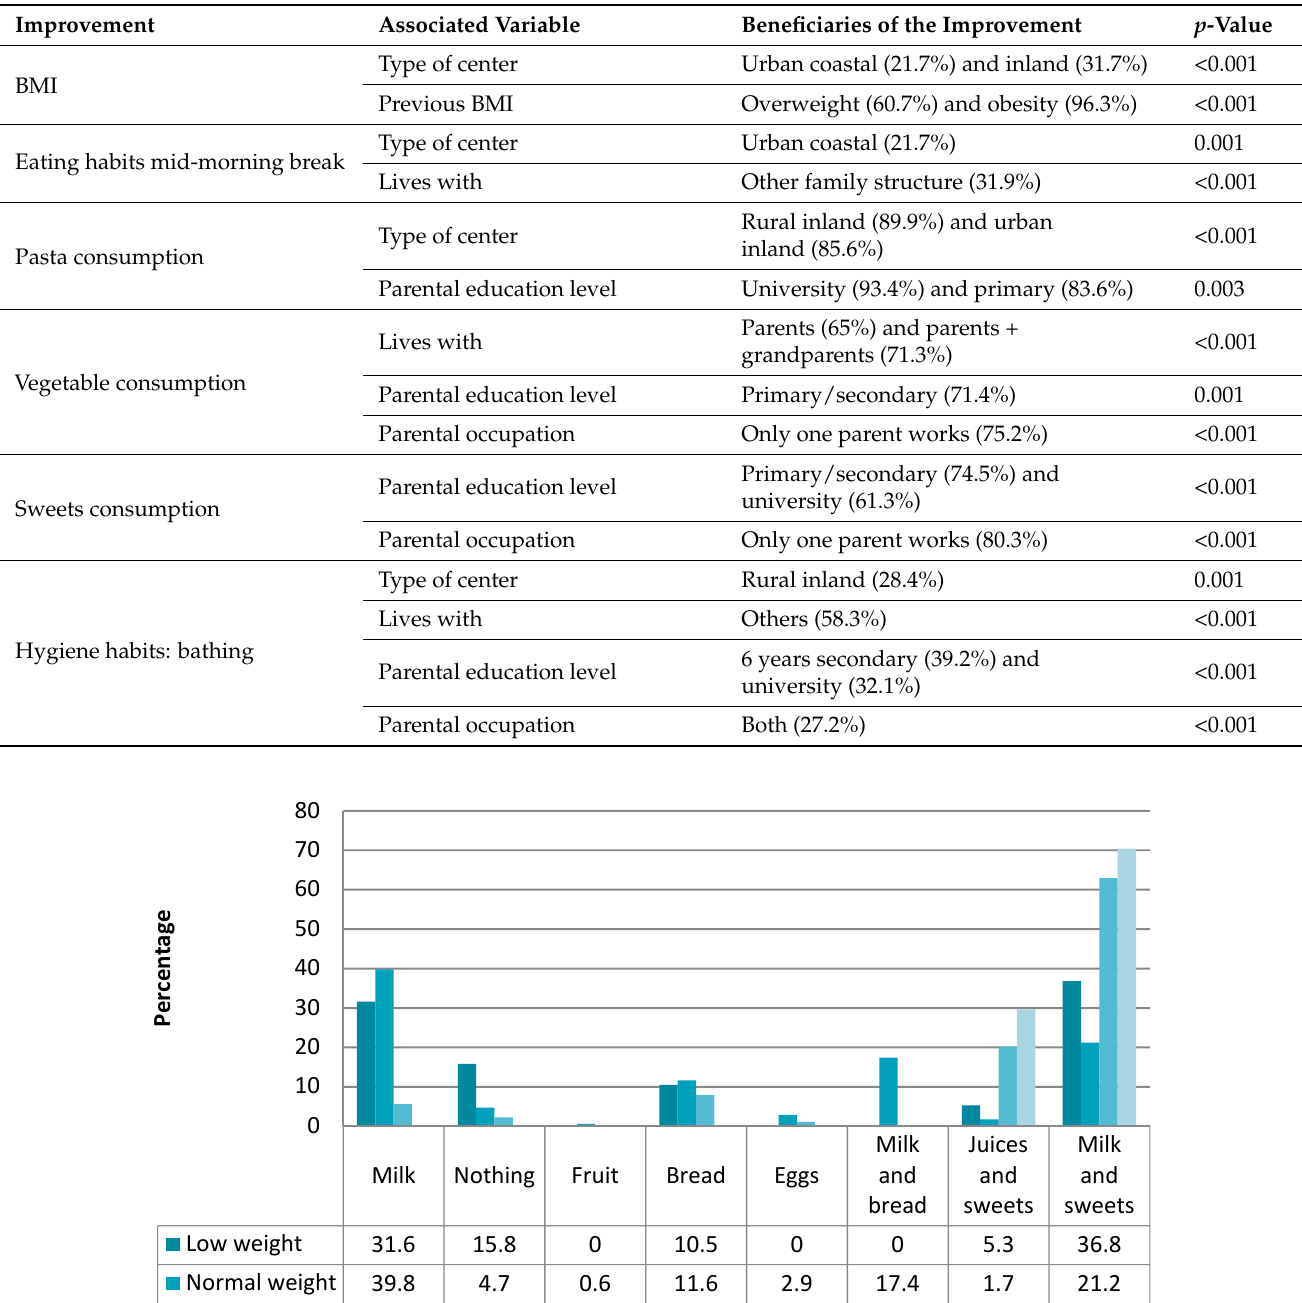
Table 3. Results of the intervention according to beneficiary variables and beneficiaries of the improvement.